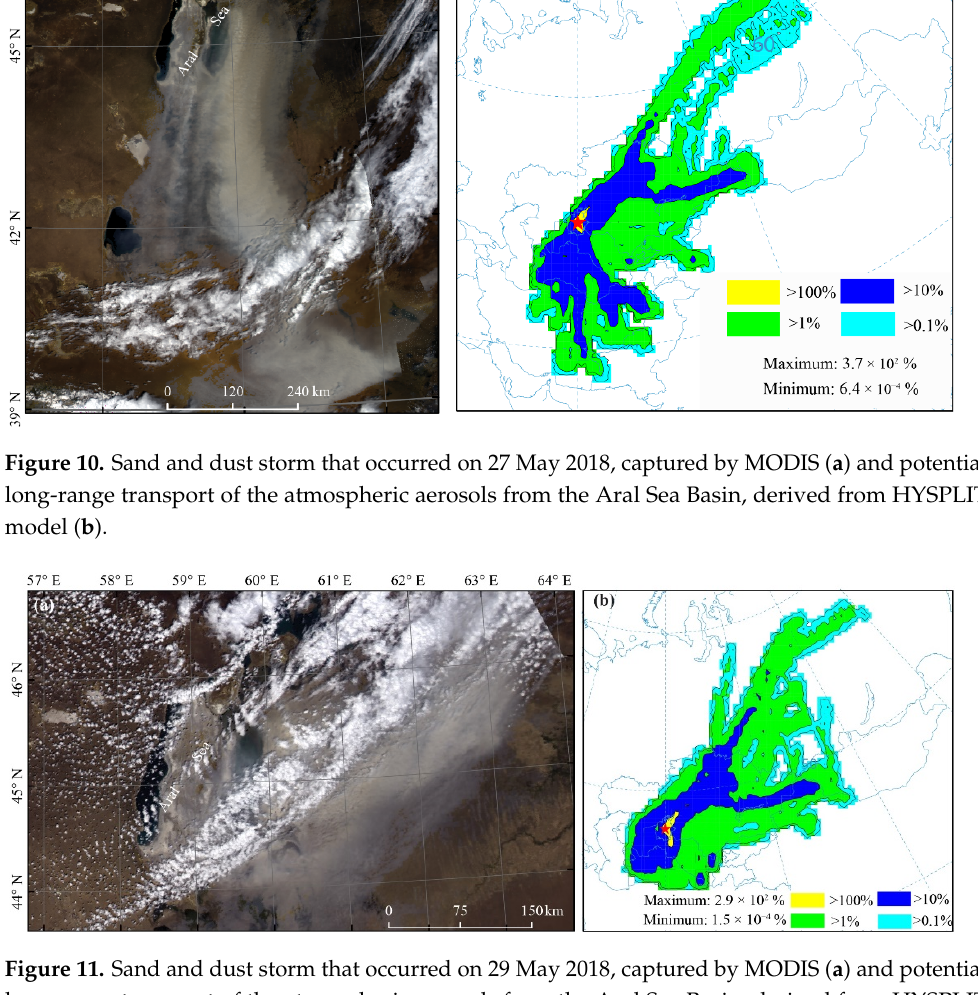
Figure 10. Sand and dust storm that occurred on 27 May 2018, captured by MODIS ( a ) and potential long ‐ range transport of the atmospheric aerosols from the Aral Sea Basin, derived from HYSPLIT model ( b ).